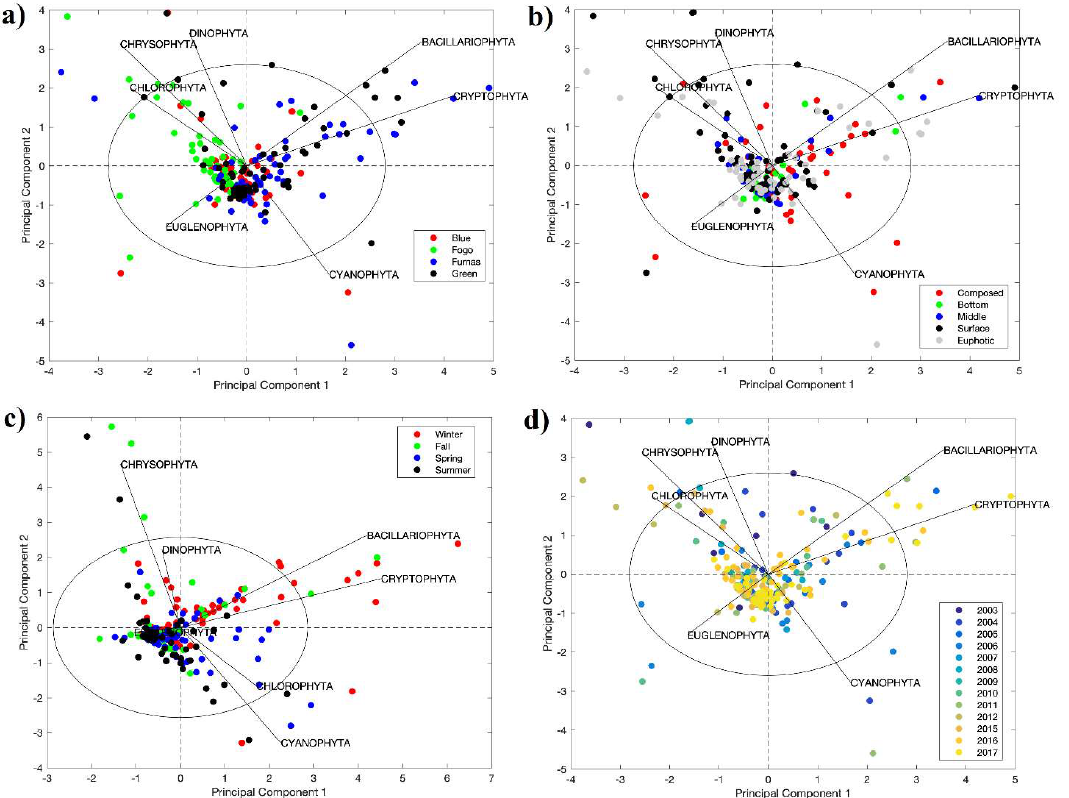
Figure 2. Biplots for the multivariate analysis of abundance (cells/L) considering phytoplankton descriptors colored according to ( a ) lakes, ( b ) depths of sampling, ( c ) seasons and ( d ) years from data collection.